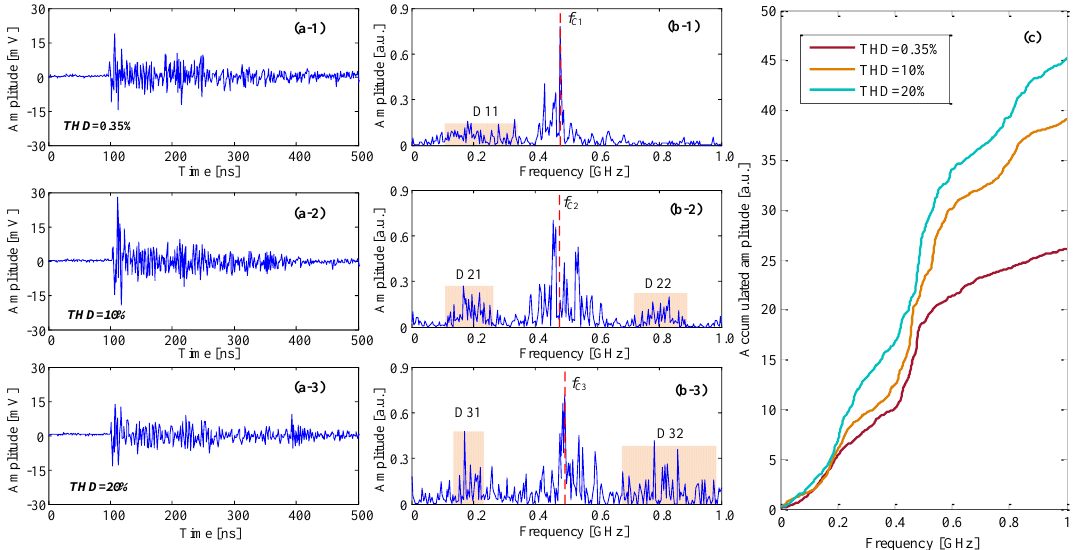
Figure 7. UHF waveform, FFT spectrum and accumulated spectrum amplitude of PD signals for model a under a mixed AC voltage with different test conditions. ( a-1 – a-3 ) the UHF waveforms with different THD content, ( b-1 – b-3 ) the FFT spectra of different UHF waveforms, ( c ) the accumulated spectrum amplitude of different UHF spectrums.